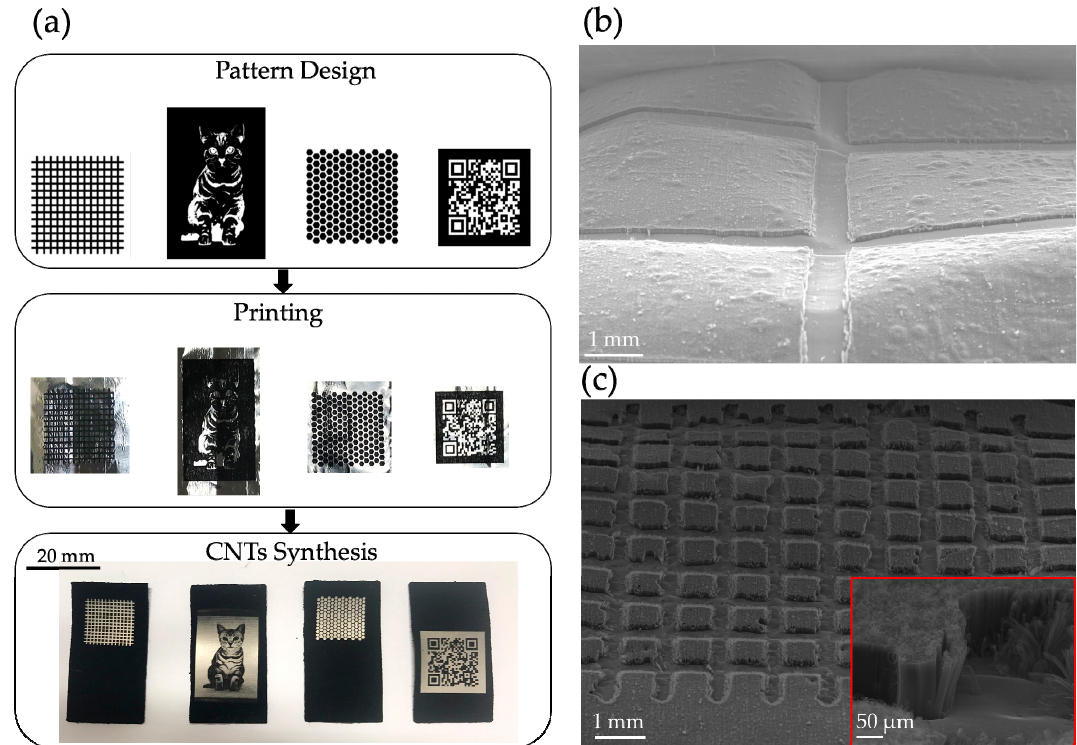
Figure 5. ( a ) Ink printing was used to pattern CNT forests on aluminium foil ( b ) and the horizontal and vertical stripe patterns from Figure 5 a were observed via scanning electron microscopy (SEM) images. ( c ) Reducing line width caused ink splattering and diminished the ability of ink to block CNT forest growth.